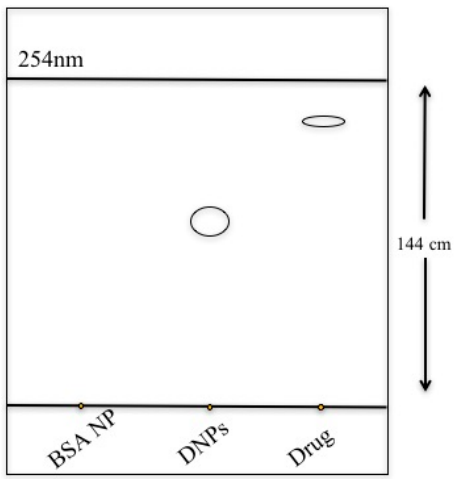
Figure 6. Thin-layer chromatography (TLC) image with the 10 µ L spot of DNPs in comparison to native BSA NPs and luminespib on TLC plate as controls. The solvent front was run for 144 cm to calculate R f values for respective mobility of spots for BSA NPs, DNPs and native drug. Our results show a real time shifts in the spot position for luminespib from DNPs in comparison to native drug. The calculated R f values were performed n = 3 times and average were taken to determine the shift in the position of spots.